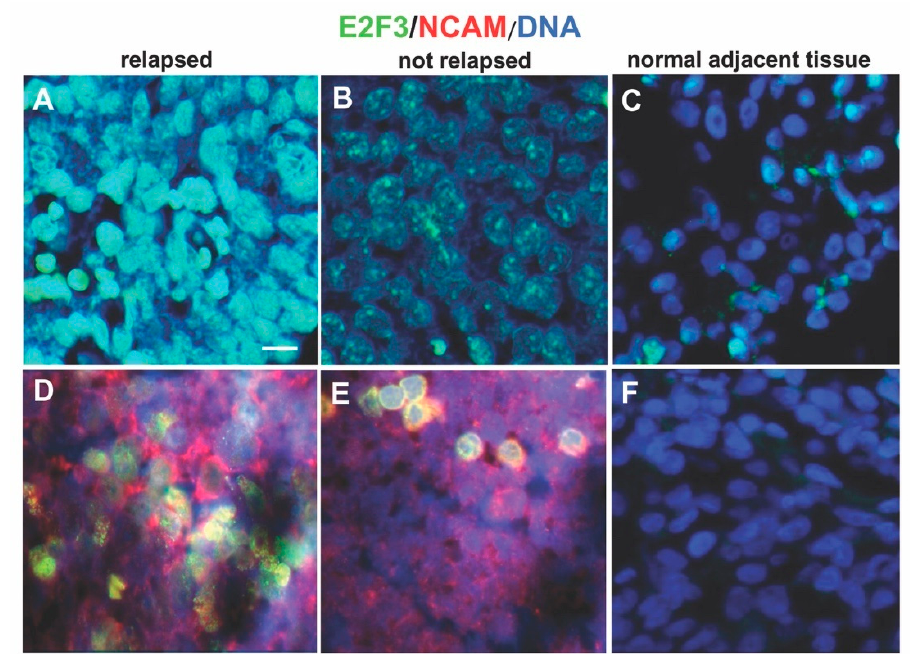
Figure 3. Expression of E2F3 protein. Immunofluorescence assay was performed to test the expression of E2F3 protein in neuroblastoma 4S tissues using the anti-E2F3 antibody. ( A ) Representative image showing brilliant green nuclear staining for E2F3 present in one specimen out of the 14 relapsed patients analyzed. ( B ) Representative image presenting weak green nuclear staining of E2F3 detected in one sample from not relapsed patients. ( C ) E2F3 protein expression in normal adjacent tissues. ( D , E ) Representative images of tumor cells (red) identified using the NB specific marker NCAM (CD56). ( F ) Normal adjacent tissues negative for NCAM. DAPI was used for DNA staining and is shown as blue. Three independent experiments were performed. Scale bars: 25 µm.